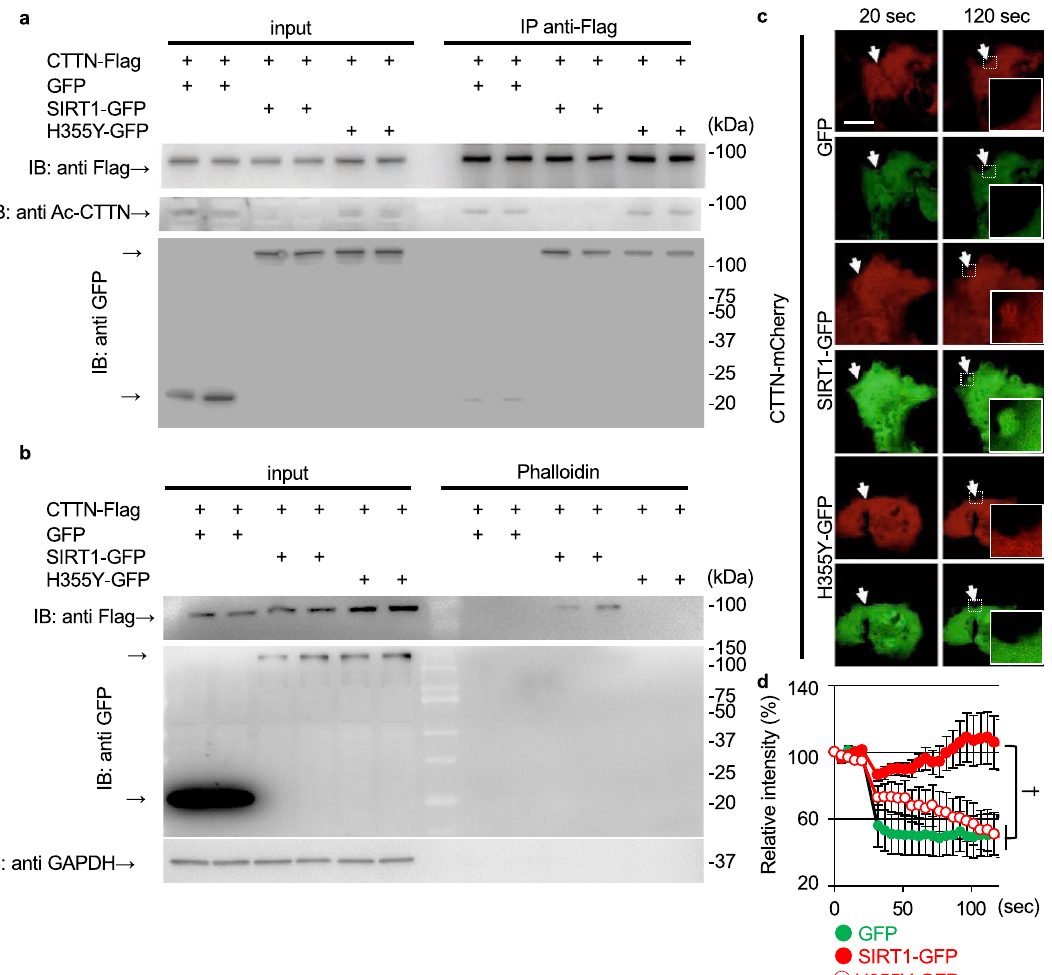
Figure 5. SIRT1 deacetylates cortactin and promotes actin accumulation at the membrane injury site. ( a ) COS7 cells transfected with CTTN-Flag and GFP, SIRT1-GFP, or deacetylase-defective SIRT1 mutant (H355Y)-GFP were lysed for immunoprecipitation. Lysate was immunoprecipitated with anti-Flag mouse IgG and was assessed using anti-Flag antibody (top), anti-acetylated CTTN antibody (Ac-CTTN; middle), and anti-GFP-antibody (bottom). ( b ) Immunoblots for Flag and GFP of lysates and sediments pulled down with Biotin-XX-Phalloidin from COS7 cells expressing CTTN-Flag and GFP, SIRT1-GFP or H355Y-GFP. ( c ) COS7 cells were transfected with CTTN-mCherry and GFP, SIRT1-GFP, or H355Y-GFP. Representative images of GFP (green) and CTTN- mCherry (red) immediately after and 100 s after laser injury. Arrows indicate injured sites. ( d ) The intensity of CTTN-mCherry at the injured site (n = 7). Data are represented as means ± SEM. A significant difference was determined by a one-way ANOVA followed by post hoc comparison with Tukey–Kramer HSD test.: †indicates P < 0.05 at last time point (120